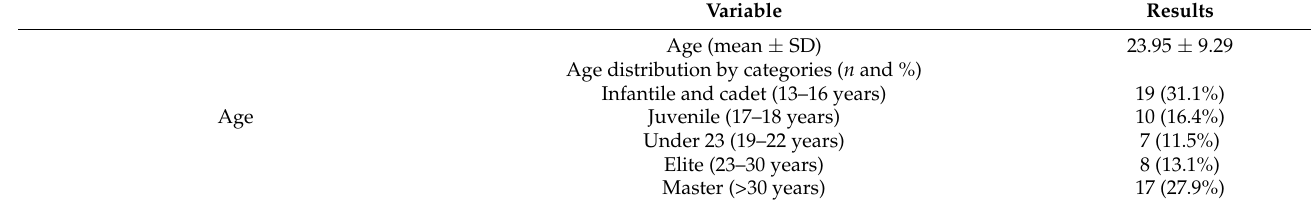
Table 1. Characteristics of women